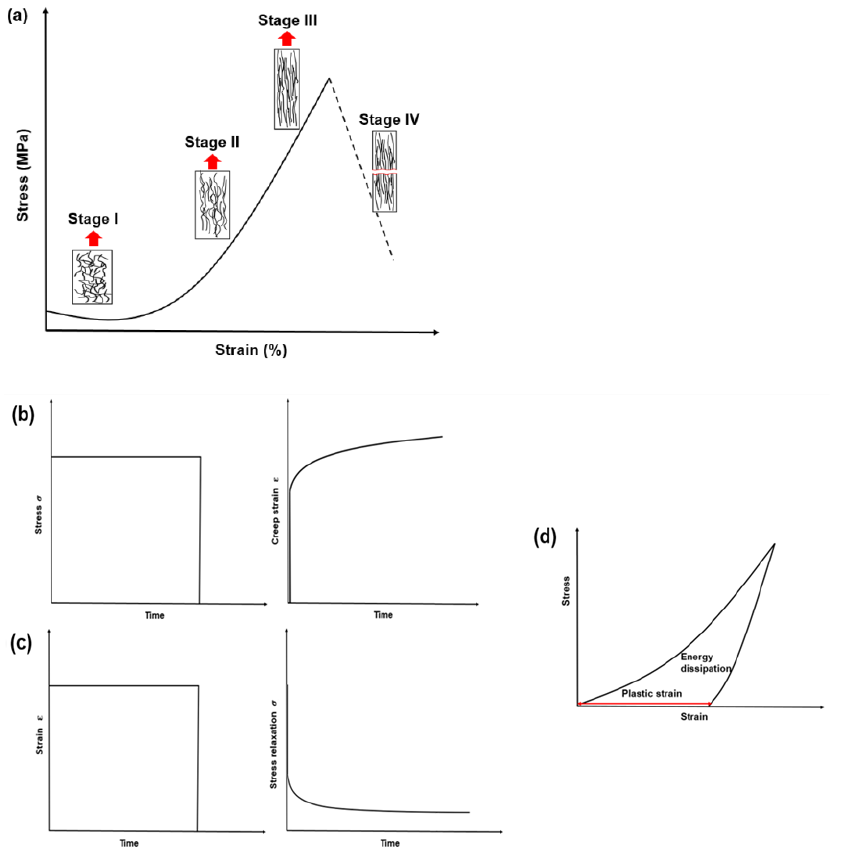
Figure 2. ( a ) Schematic representation of the arrangement of collagen fibres with increasing strain during tensile loading resulting in stiffening. Viscoelastic effects: ( b ) creep; ( c ) stress relaxation; and ( d ) energy dissipation in cyclic loading (only one cycle shown).